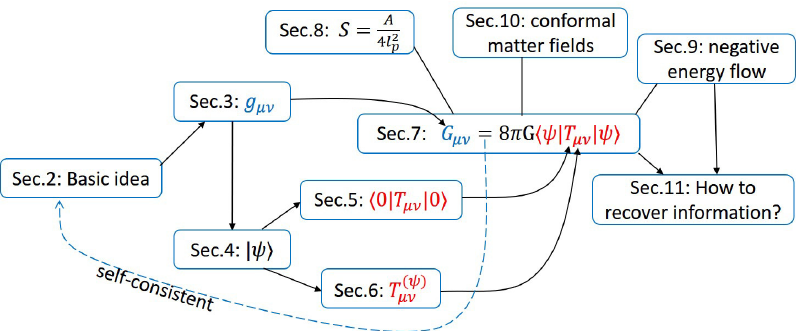
Figure 2. Flow chart of the composition of this